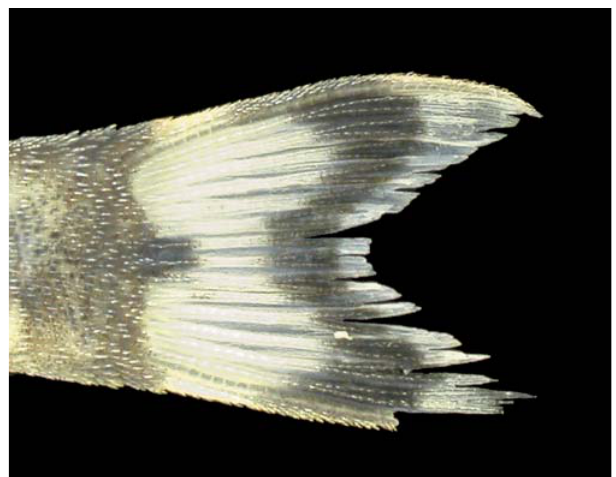
S Fig. 3. Caudal peduncle of Otocinclus cocama , paratype, MCP 34842, 36.2 mm SL. Odontode swirl forming a contact organ (arrow), a male sexual dimorphism in the arrangement of odontodes near the